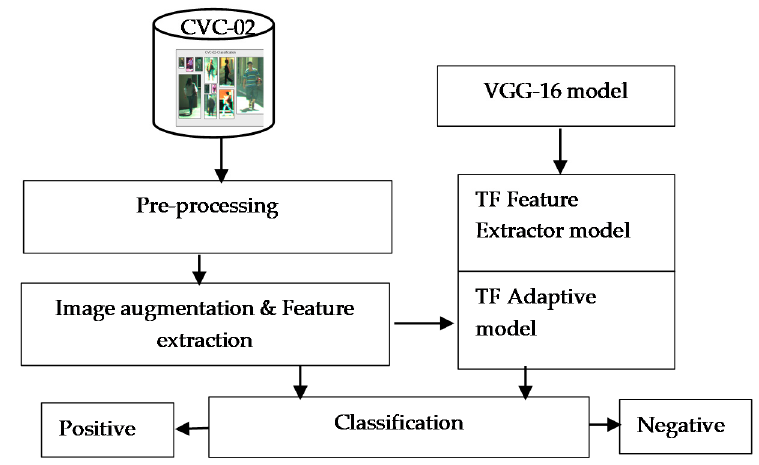
Figure 2. Concept of our proposed method.